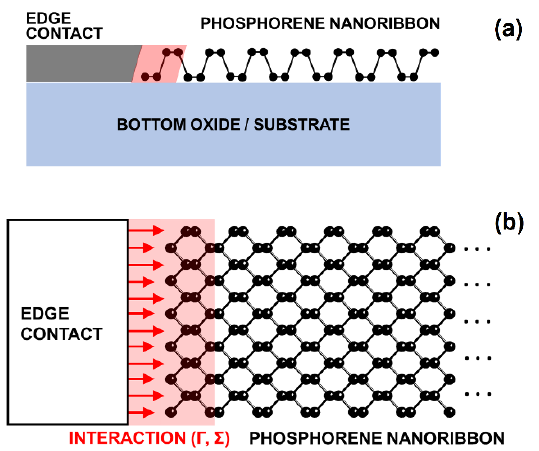
Figure 1. ( a ) Side-view and ( b ) top-view of the left metal edge contact attached to the PNR. Light red shaded area indicates the extent of metal-nanoribbon interaction across the closest super-cell, described by the broadening parameter ( Γ ) or contact-self energy ( Σ ).